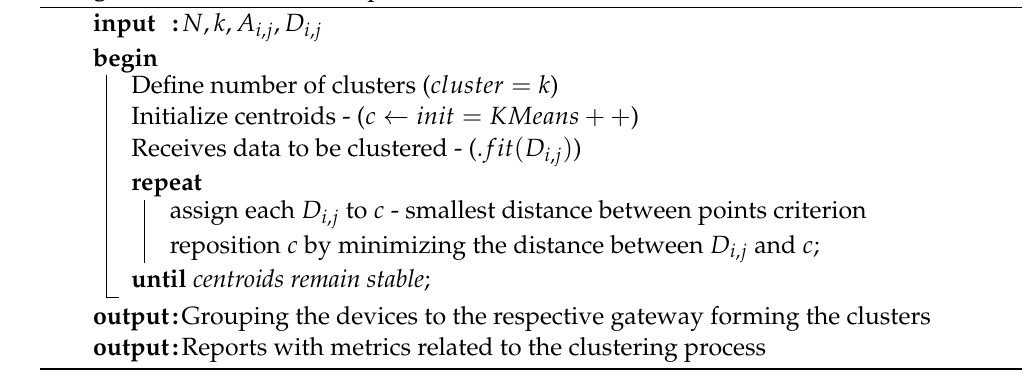
Algorithm 1: The K-means pseudocode.